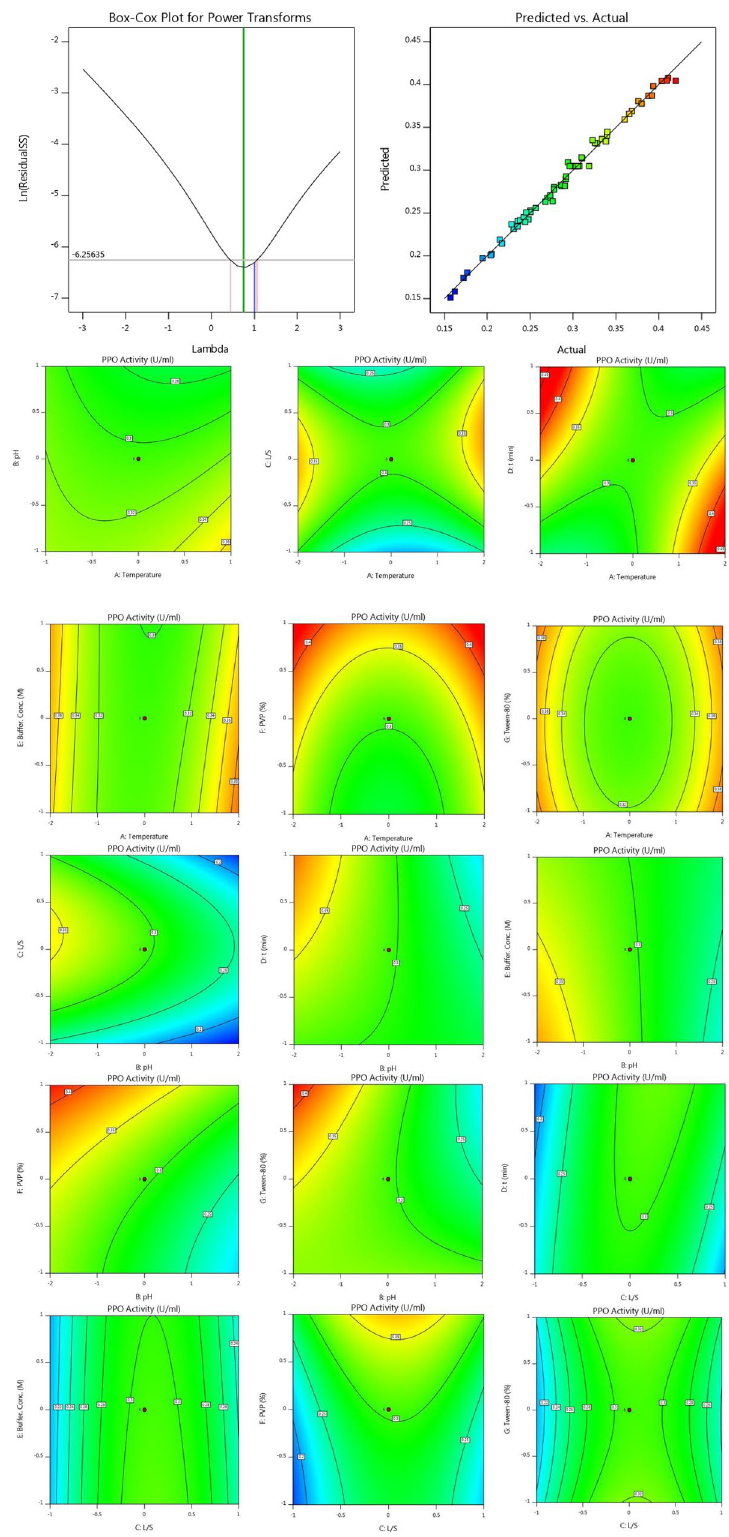
Figure 2. The plot of relationship between predicted and actual values of PPO enzyme activity and Contours of the effect of seven parameters on PPO enzyme activity and 3D response surface plots for the effect of seven parameters on PPO enzyme